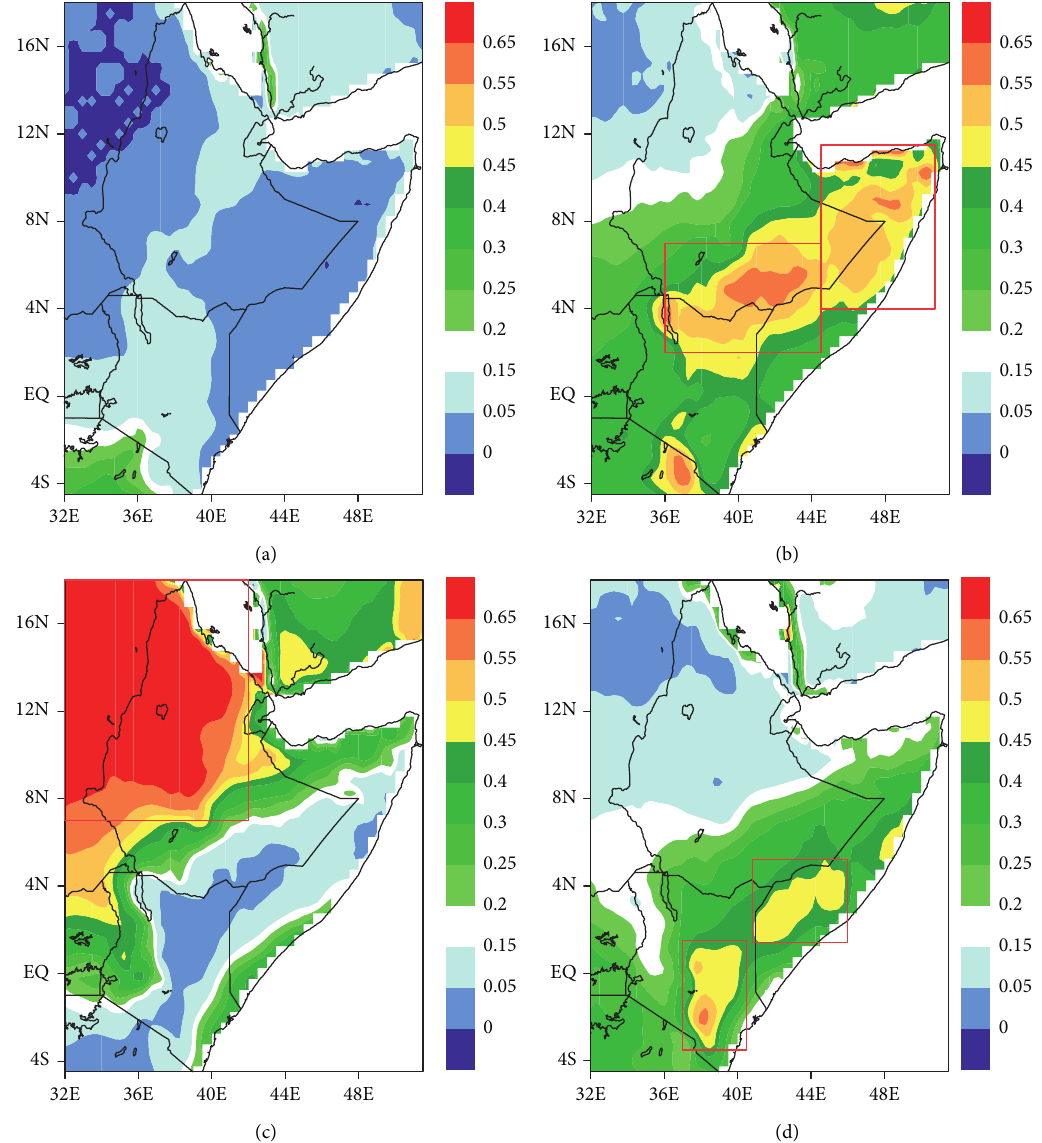
Figure 2: Seasonal fraction of annual rainfall for the seasons (a) January-February, (b) March-May, (c) June-September, and (d) October- December. The monthly value obtained from gridded datasets of CRU TS4.01 for the period 1979–2016. Red boxes mark the region we chose for studying, which accounts for greater than 45% of annual